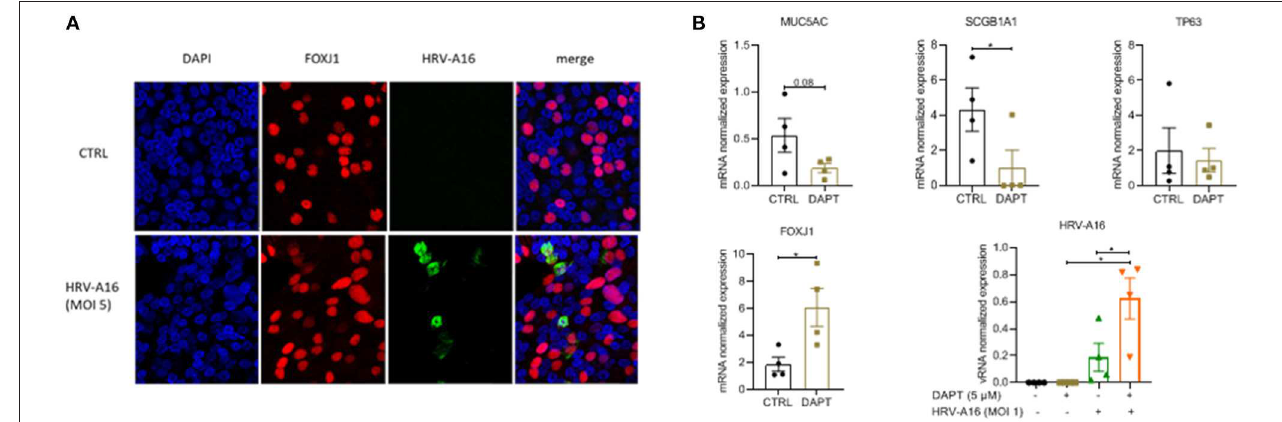
FIGURE 2 | The target of HRV-A16 in human bronchial epithelial cells. (A) At 8h after HRV-A16 infection, cells were fixed in 4% paraformaldehyde solution and stained using immunofluorescence with mouse anti-HRV-A16 antibody (green), primary antibodies against FOXJ1 (ciliated cell marker, red) in combination with 4 ′ ,6-diamidino-2-phenylindole (DAPI) for nuclear staining (blue). Images shown are representative for results obtained with cells from four different donors with 630 x original magnification ( n = 4). (B) PBEC were differentiated for 14 days in the presence of either 5 uM DAPT or solvent control. On day 14, cells were infected by HRV-A16 (MOI 1). After infection, the basal medium was replaced by fresh medium contain 5 uM DAPT or solvent control. Cultures were incubated for 24h before harvesting lysis of cells for isolation of RNA. The vRNA and gene expression of cell markers (MUC5AC, SCGB1A1, TP63, and FOXJ1) were measured by qPCR. Data are mean values ± SEM. Data are shown as target gene expression normalized for RPL13A and ATP5B. n = 4 independent donors. Analysis of differences was conducted using paired t -test and one-way ANOVA with a Turkey post-hoc test. Significant differences are indicated by * P < 0.01 compared with control or HRV-A16.